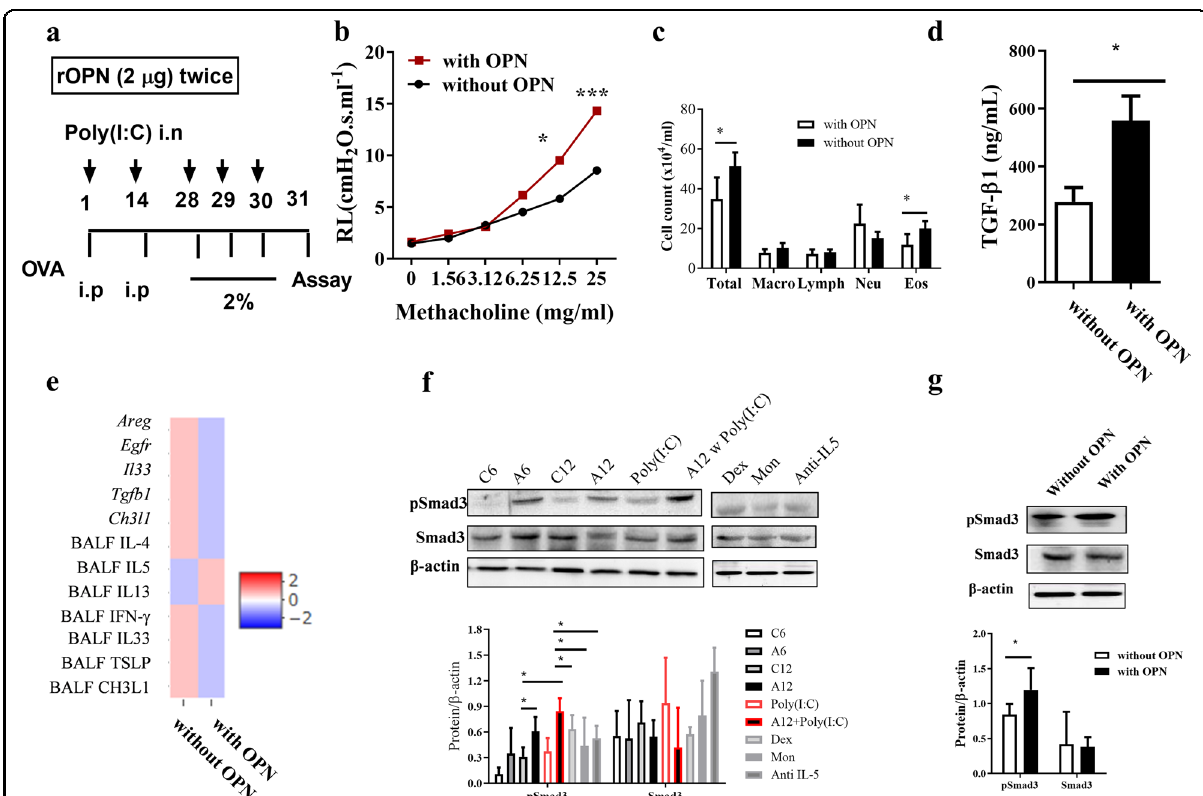
Fig. 4 Effects of OPN on the TGF- β 1/Smad3 signaling pathway. a In total, 4 μ g of recombinant OPN (rOPN) was administered to mice during the sensitization period as in the described protocol. Increased b AHR and c mixed eosinophil/neutrophil counts in BALF. d Increased TGF- β 1 levels in BALF after rOPN administration. e Changes in gene expression and cytokine levels in BALF. f and g Increased levels of pSmad3 in the lung tissues of mice, analyzed by Western blotting. Data are shown as the means ± SEM, n = 5 – 10 for each group. * P values were analyzed by the Mann –